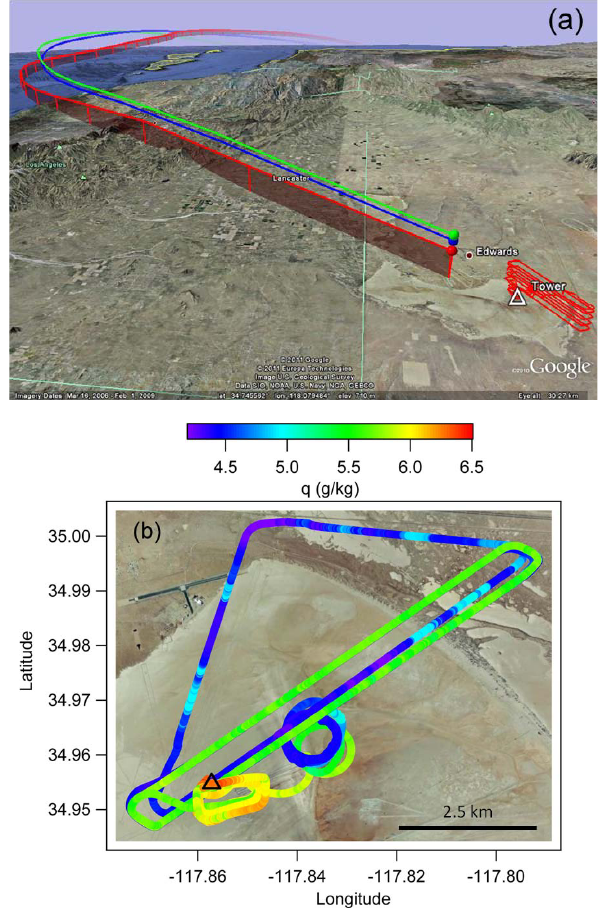
Fig. 4. (a) Regional view looking west of the NASA Dryden Flight Research Center (NDFRC) situation displaying the tower location (Triangle), flight positional data from FT A , and HYPLIT Modelled back trajectories ending at 1055, 1445 and 1645ma.g.l., 12:00p.m.PST. The distance from HYSPLIT site end points to the coast is approximately 115km. (b) Plan view of FT B flight path, colored according to water vapor concentration. Both figures use Google earth